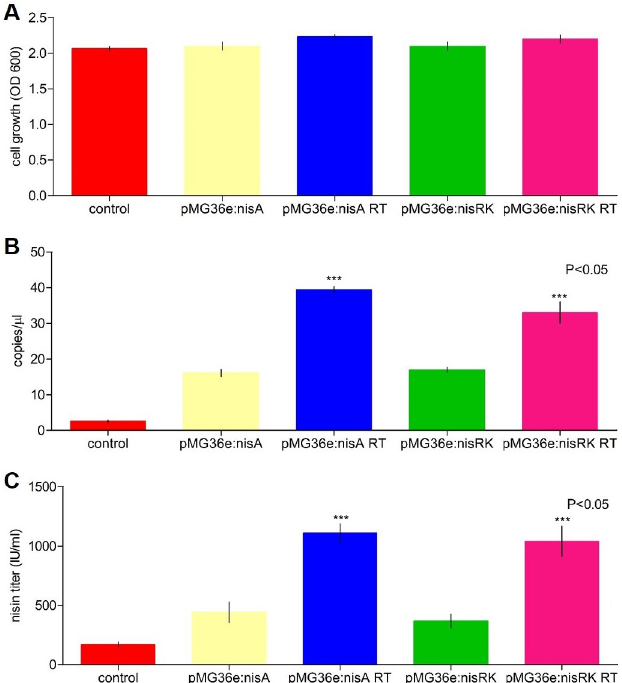
Fig 4. Characterization of the L . lactis subsp. lactis wild-type and engineered strains. (A) cell growth was evaluated through of optical density OD600 after 18 hours of fermentation. (B) the value data were determined in terms of copies of the nisA and nisRK genes / µ L of qPCR reaction. (C) the nisin A quantification was determined by activity assay in the L . lactis subsp. lactis wild-type and engineered strains. The bars represent means of three independent replicates ± standard error (P < 0.05).